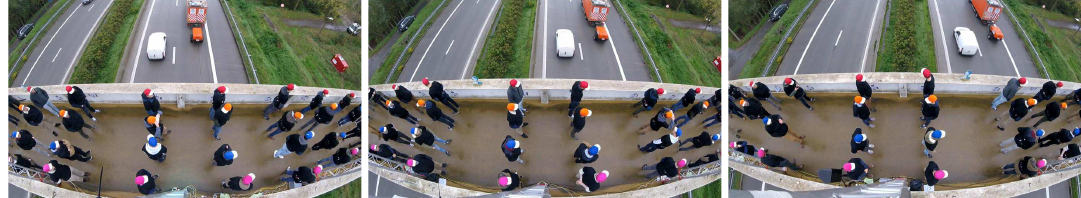
Figure 3. Example of offline synchronization of the static camera setup based on the white van passing the white road marking: static camera 9 ( left ), 10 ( middle ) and 11 ( right ).